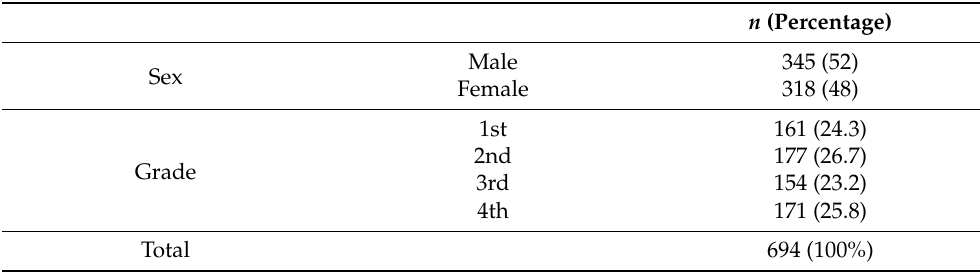
Table 1. Descriptive characteristics of the